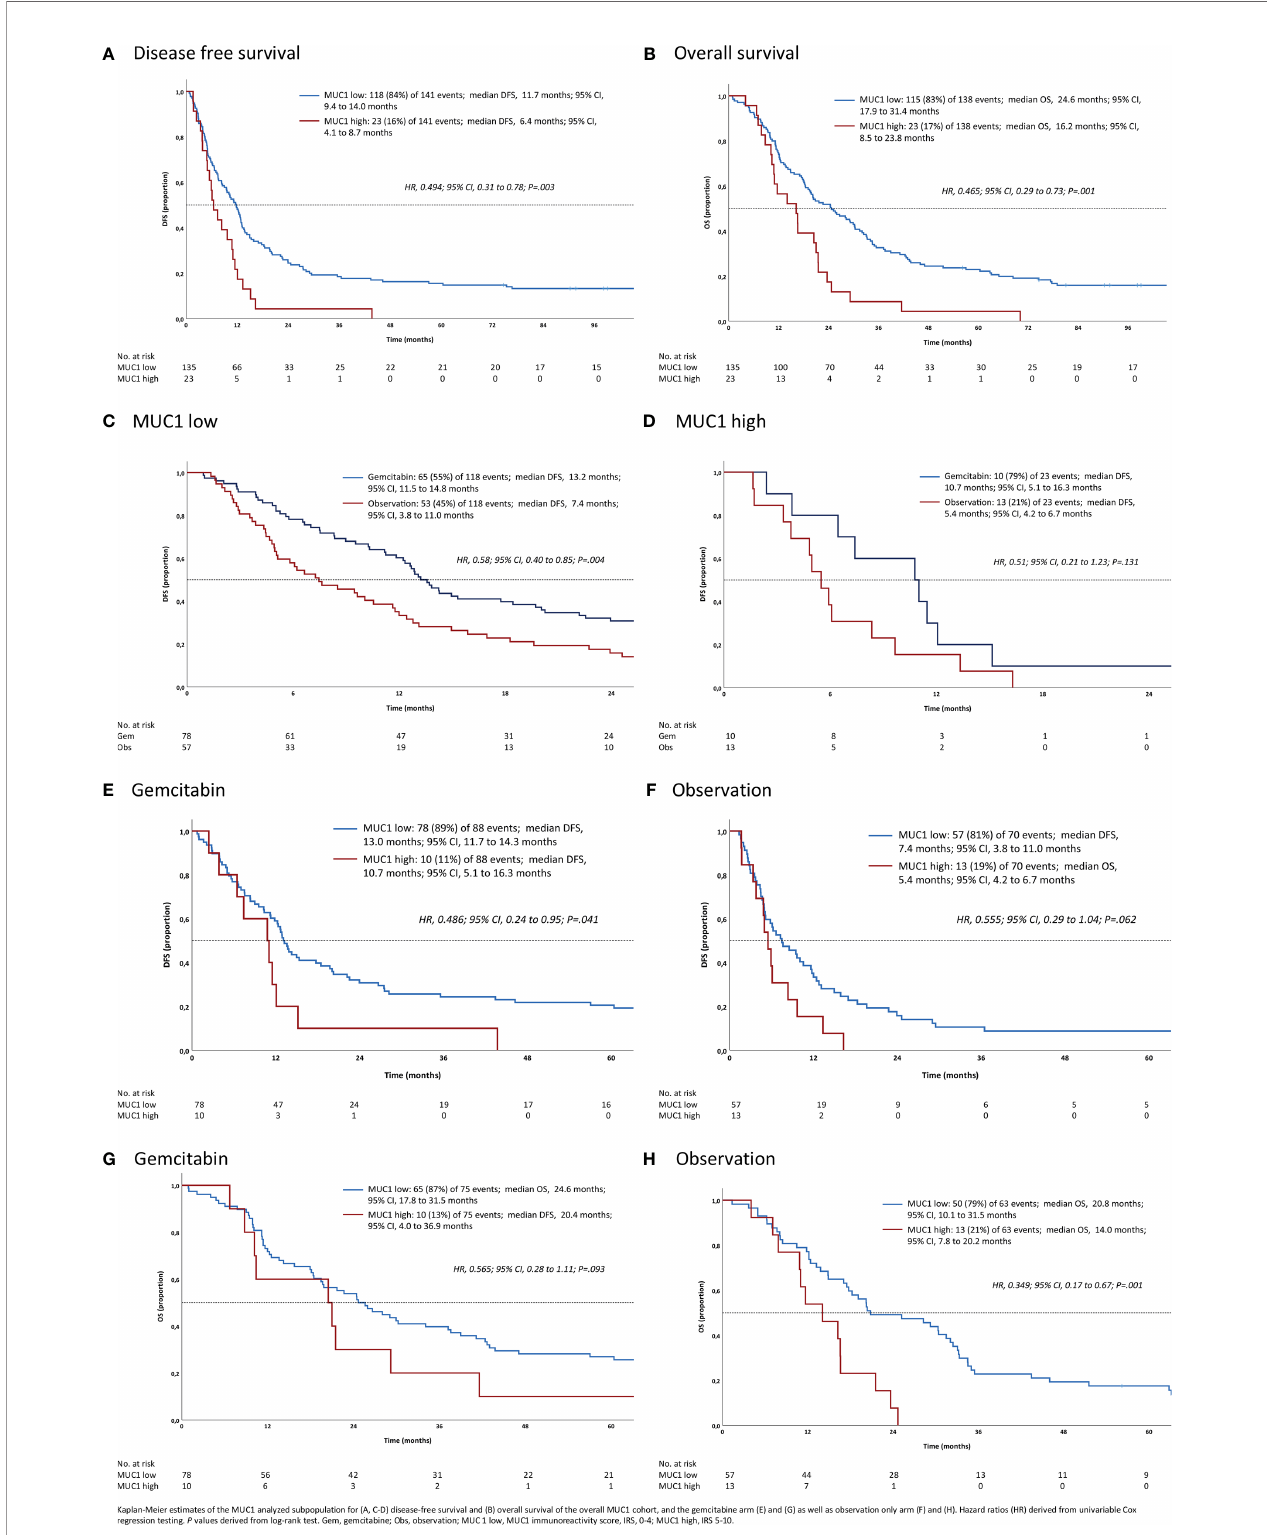
FIGURE 3 | Survival analyses in subgroups for (A – D) MUC1 low vs . high, and gemcitabine vs . observation (E – H)